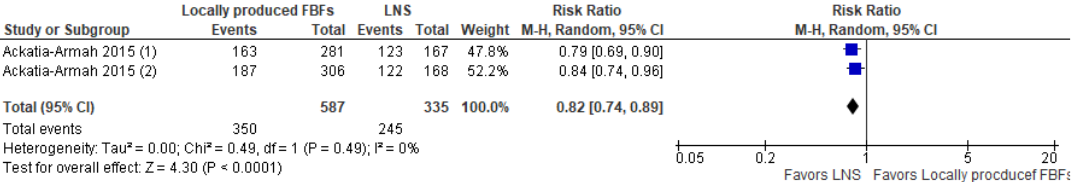
Figure 6. Forest plot of locally produced FBF compared to LNS—Outcome: Recovery rate (1) Locally milled flours (LMF) compared to RUSF; Recovery defined as WLZ > − 2.0 and MUAC >12.5 cm for >= 2 follow-up visits; (2) Misola compared to RUSF; Recovery defined as WLZ > − 2.0 and MUAC >12.5 cm for >= 2 follow-up visits.